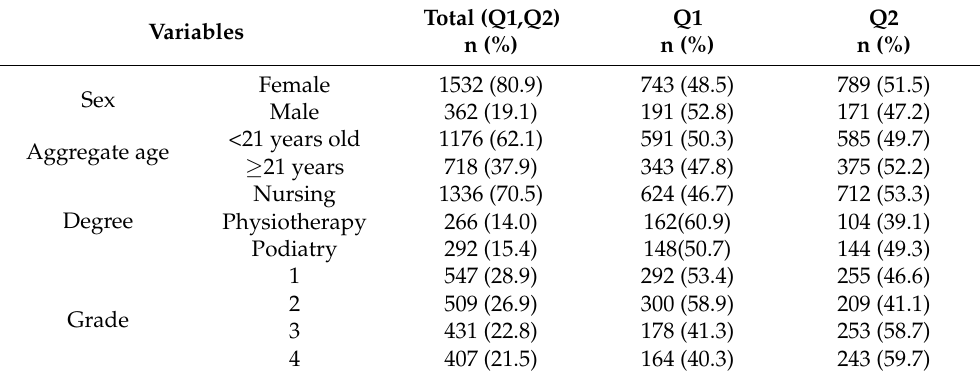
Table 1. Characteristics of the sample for Q1 and Q2.